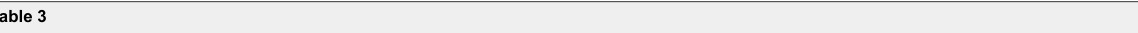
Table 3 The frequency and nature of drug-drug-interactions (DDI) in 2010 over all clinics, separated in severity categories 1, 2 and 3. As more than one drug pair can result in a same DDI category alert within a given prescription, the number of drug pairs exceeds the number of DDI outlined in table 2. In category two and three, only the top ten drug pairs are indicated. In category one, four drug-pairs account for 97% of all DDI. In category two and three, the top ten DDI account for 52% and 57% of all DDI respectively. For category 3, due to the huge amount of different drugs used, class effects are taken together, where appropriate (e.g., angiotensin-converting enzyme inhibitors ACE). +Each single DDI not specifically outlined (others, number of specific DDI in brackets indicated) accounts for less than 2% of all DDI. *Nutriflex is a commercially available, parenteral nutrition solution (ATC B05BA10). ACE: angiotensin-converting enzyme inhibitor ARB: angiontensin-receptor blocking agent NSAID: non-steroidal anti-inflammatory